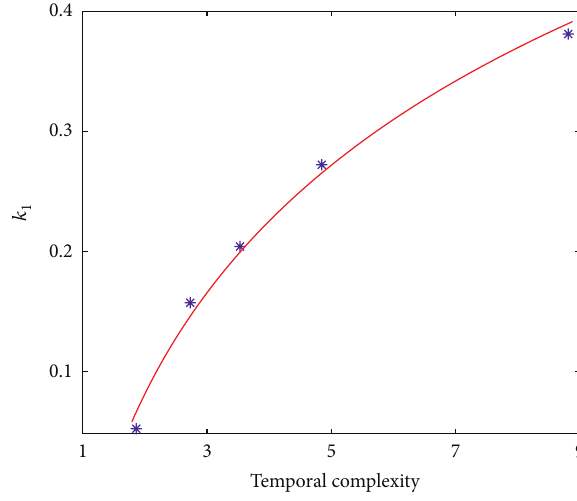
Figure 6: Relationship between 𝛿 𝑡 and the slope 𝑘 1